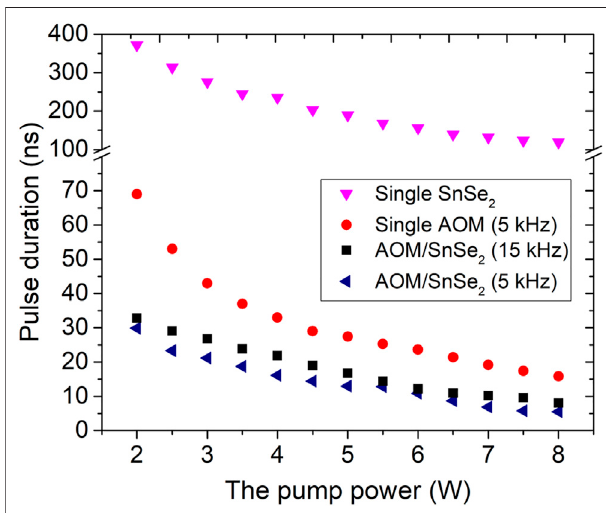
FIGURE 5 | Pulse duration versus pump power of SnSe 2 singly, AOM singly and AOM/SnSe 2 doubly Q-switched lasers with different f A .